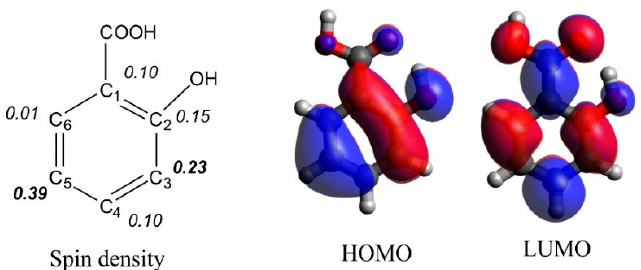
Figure 2. Electronic structure of salicylic acid (SA) radical: ppin density calculated by natural bond theory (NBO) method ( left ) and highest occupied molecular orbital—lowest unoccupied molecular orbital (HOMO-LUMO) ( right ).